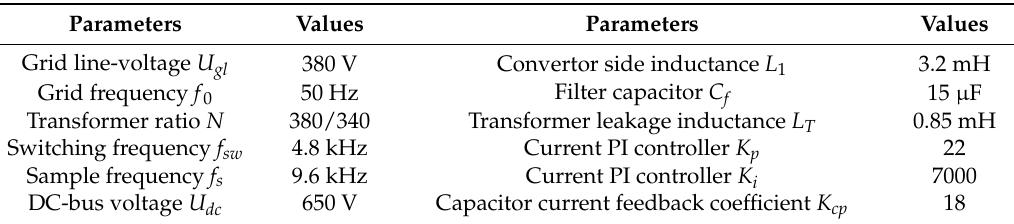
Table 1. System parameters of grid-connected converter.